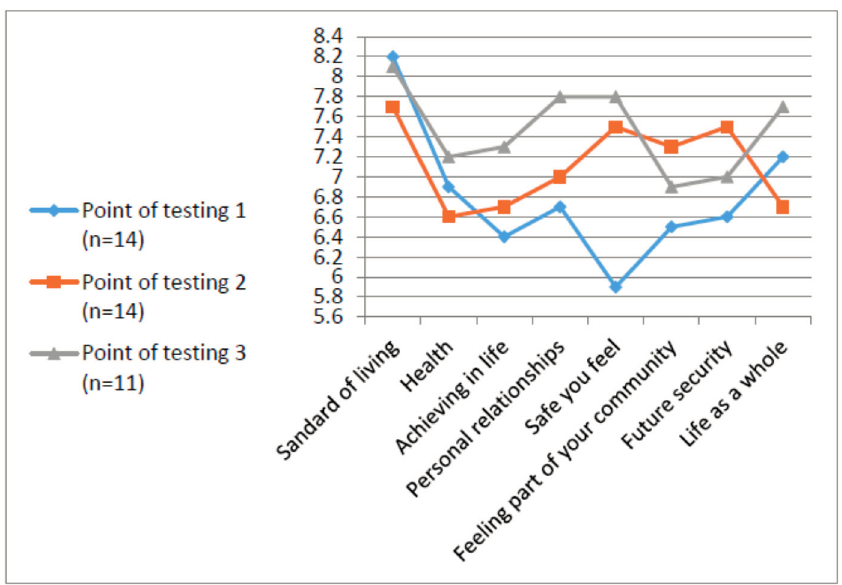
Figure 3. Comparison of personal perception of well-being by PWI in three different points of testing. Point of testing 1—at the beginning of the course; Point of testing 2— at the end of the course; and Point of testing 3—after six month of integration into army